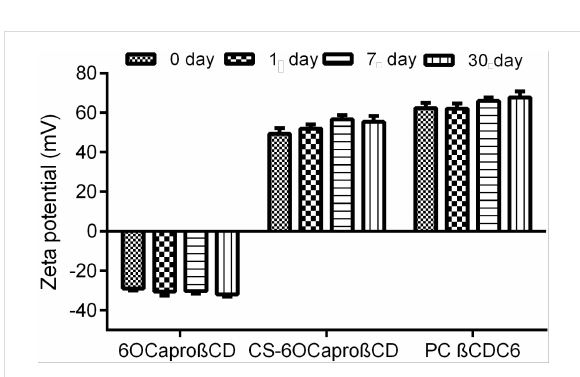
Figure 4: Time-dependent variation of the zeta potential value of PCX- loaded amphiphilic CD nanoparticles stored in aqueous dispersion form ( n = 3, ± SD).